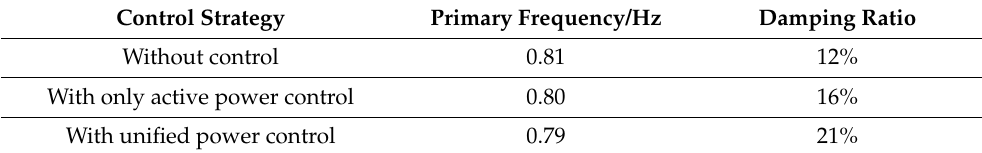
Table 4. The Damping ratio changing situations with different